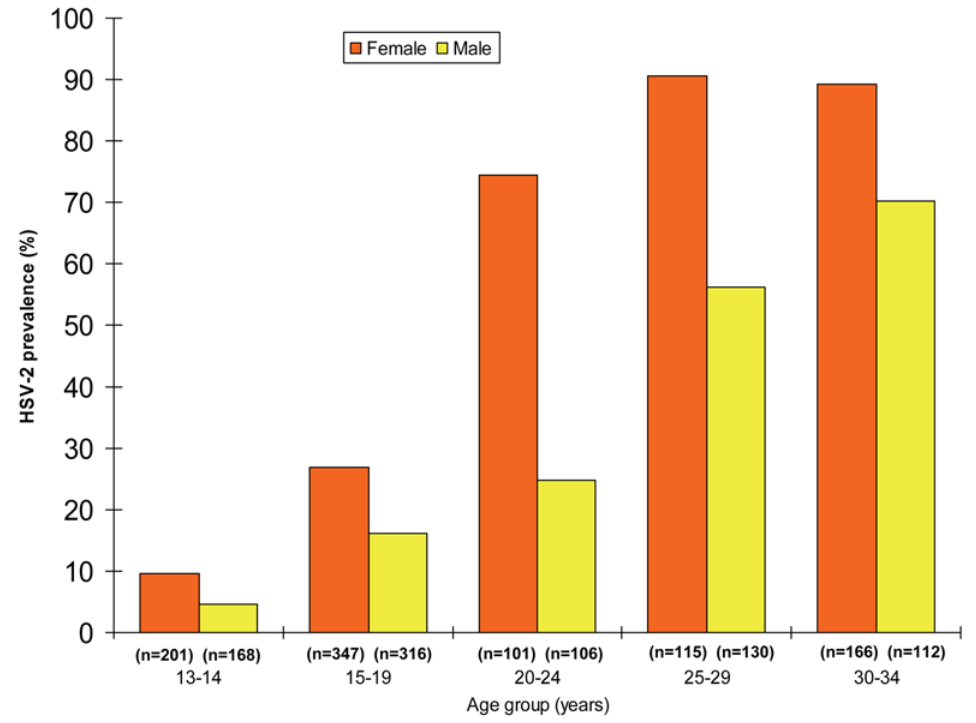
Figure 2. HSV-2 prevalence by sex and age group, N=1762.